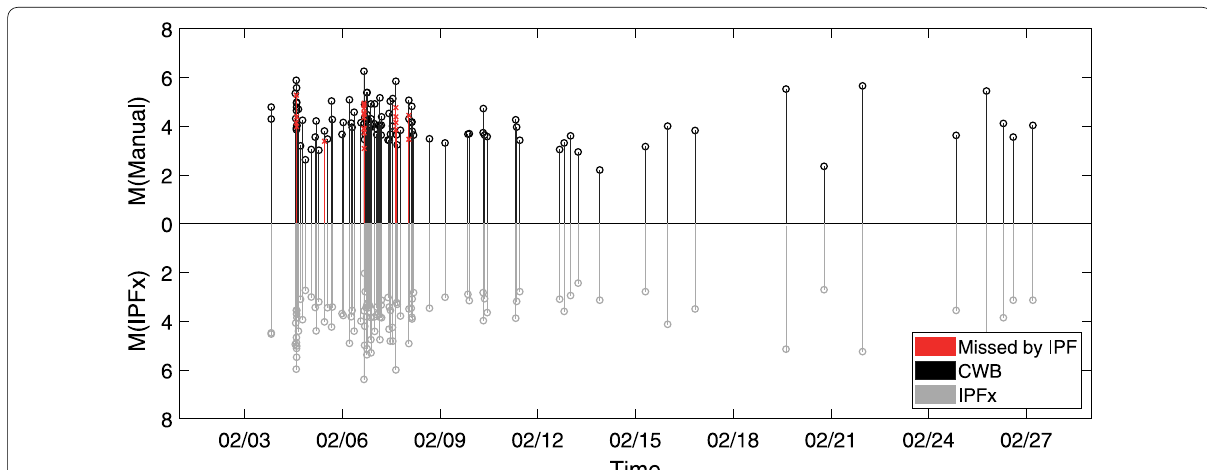
Fig. 7 Time frame of the earthquakes detected by the IPFx method (bottom) and CWB manual catalog (top) for February 2018. The red bars indicate the earthquakes missed by the IPFx method